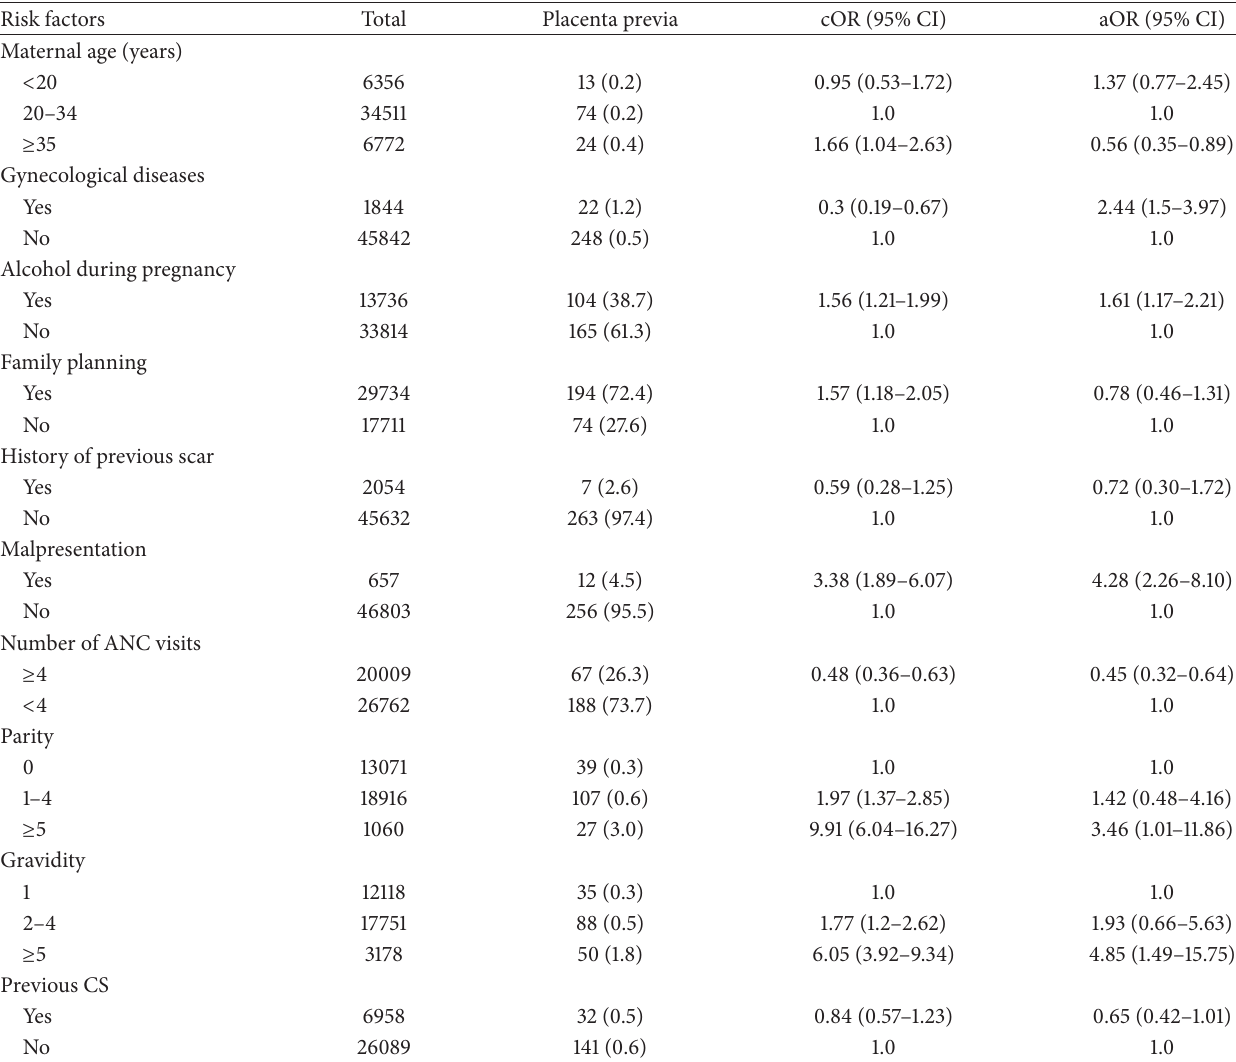
Table 2: Logistic regression of risk factors for placenta previa in Northern Tanzania ( 𝑁 = 47